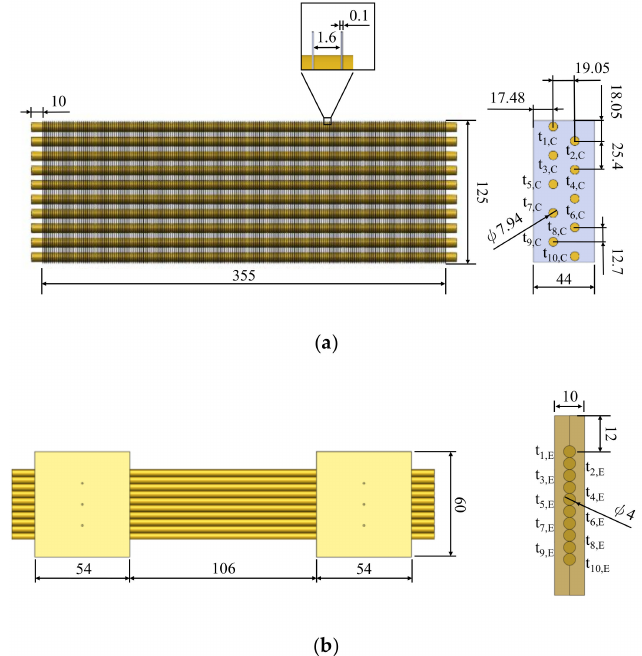
Figure 6. Detailed dimension of the ( a ) heat exchanger ( b ) cold plate (unit: mm).